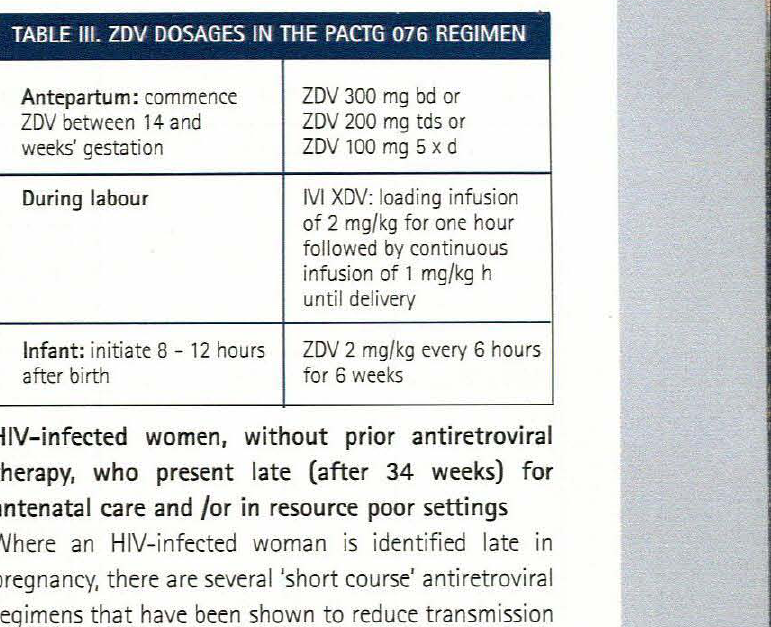
TABLE Ill. ZDV DOSAGES IN THE PACTG 076 REGIMEN Antepartum: